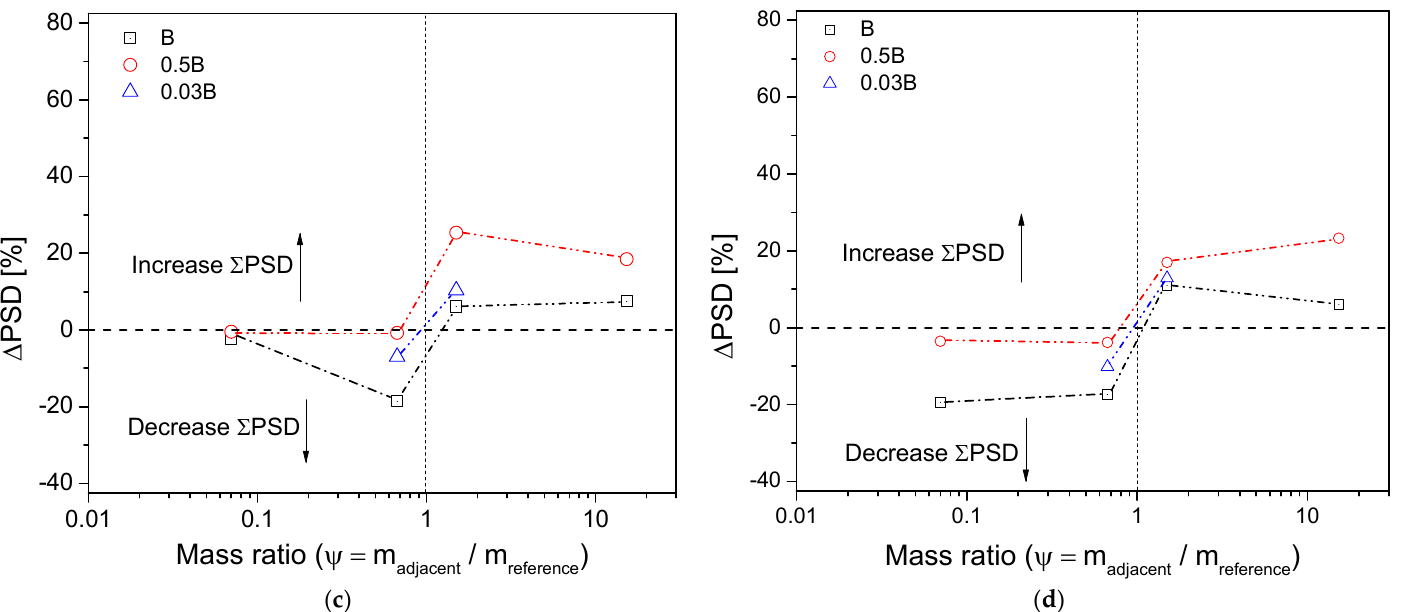
Figure 11. Variation of ΔPSD with mass ratio suffered from ( a ) L_Input of artificial EQ; ( b ) L_Input of Hachinohe EQ; ( c ) H_Input of artificial EQ; and ( d ) H_Input of Hachinohe EQ.